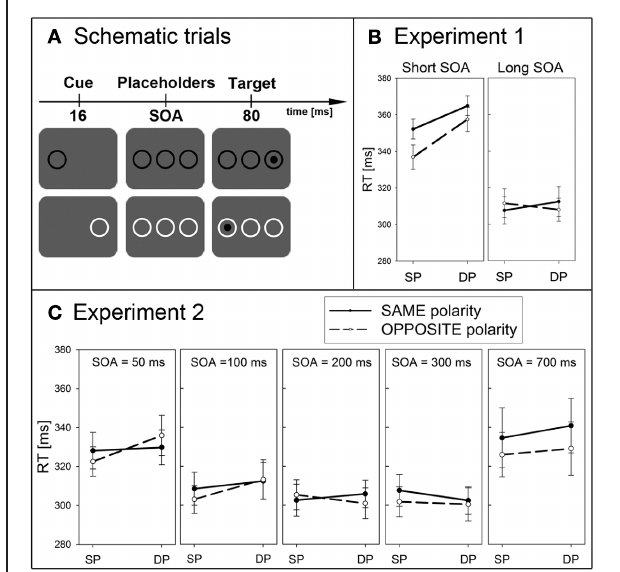
FIGURE 1 | (A) Depicted are schematic trials. The top row shows a dark target on the right side, cued by a dark cue at the left side (same-polarity and DP condition). The bottom row also depicts a dark target, but preceded by a light cue and again on the different position (opposite-polarity and DP condition). (B) Depicted are mean RTs (between 280 and 380ms) and standard errors of the mean (error bars) of all participants, plotted separately for the short (left panel) and long SOA (right panel) of Experiment 1. Results are shown for SP (left side of each panel) and DP conditions (right side of each panel), and plotted separately for same- (solid lines) and opposite-polarity cues (dashed lines). (C) Depicted are mean RTs (between 280 and 380ms) and standard errors of the mean (error bars) of all participants, plotted separately for the five different SOAs (separate panels, from left to right for SOA = 50, 100, 200, 300, and 700ms) of Experiment 2.